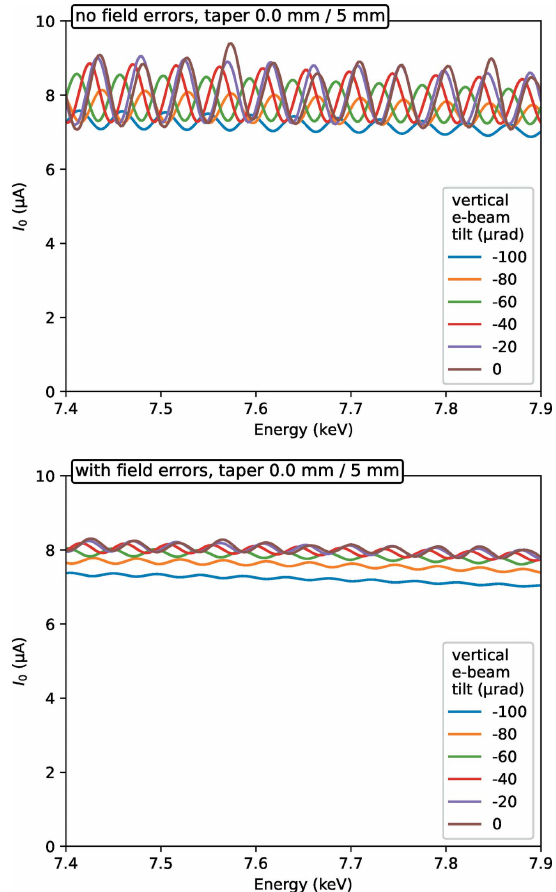
Figure 3 Calculated wiggler spectra at various e-beam inclination and taper values of the magnetic gap. Top: with the ideal magnetic field; bottom: with the magnetic field corrected for the measured field errors. An animated version of the figure can be found in the supporting